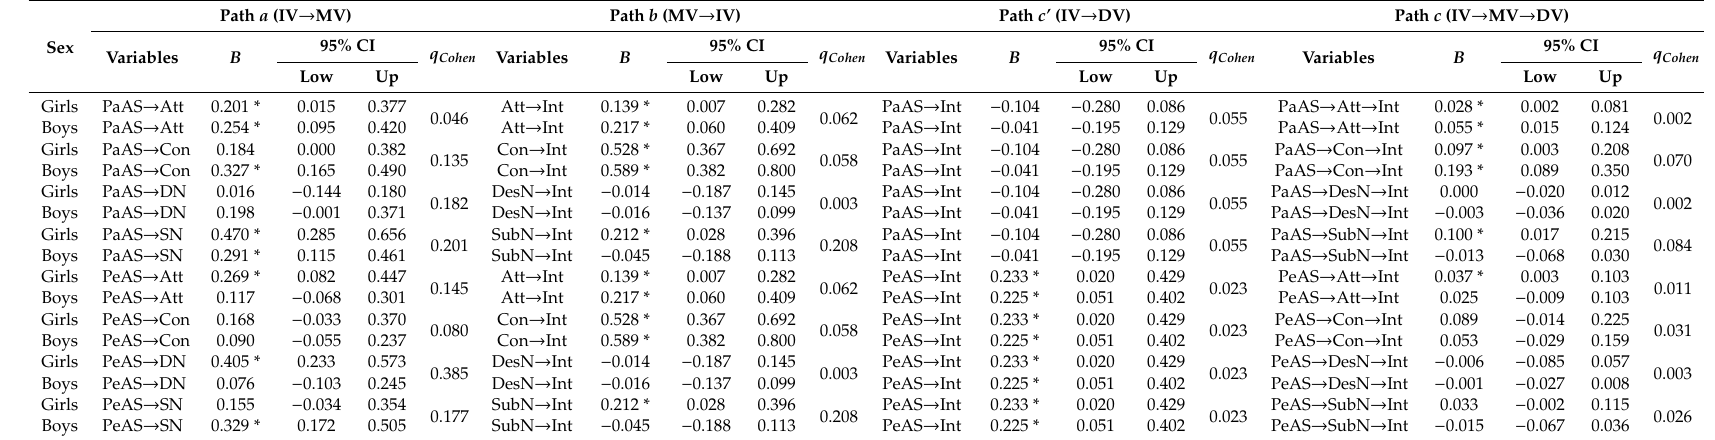
Table 2. Direct and Indirect E ff ects of the Tested Mediation